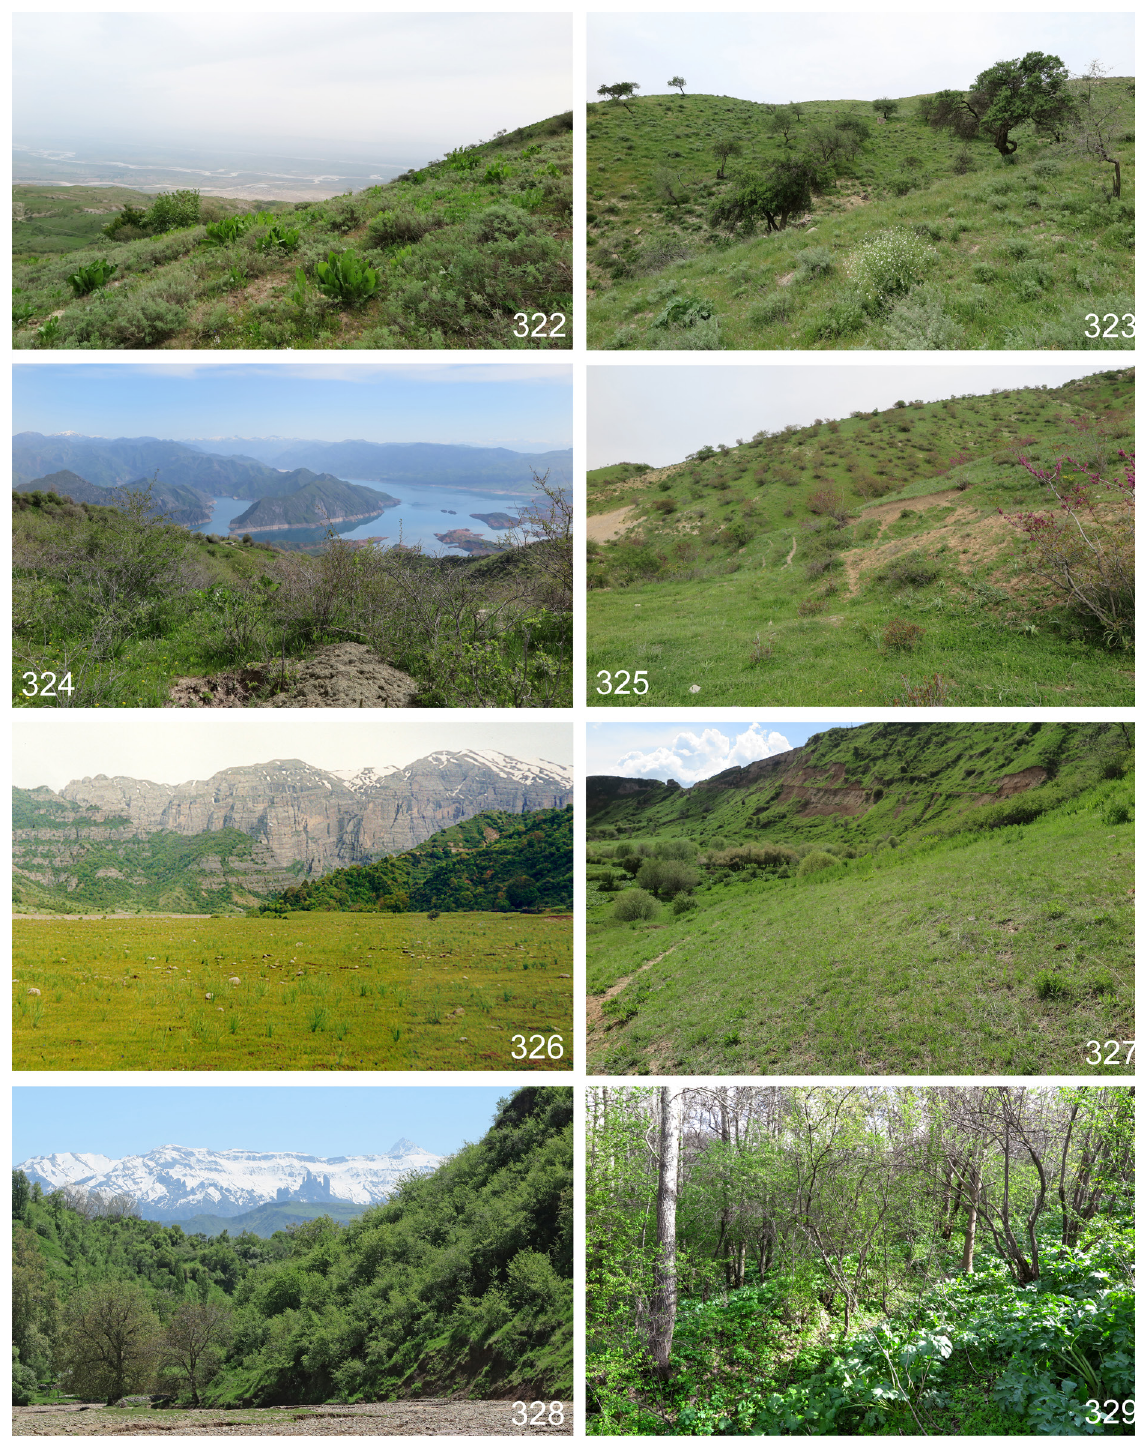
Figs 322–329. Anemesia spp., habitats of A. infumata sp. nov. (322–323), A. parvula sp. nov. (324) and A. infuscata sp. nov. (324–329); Tajikistan. 322–323 . Summit part of Panj Karatau Mts north of the Panj River bordering Tajikistan and Afghanistan. 324–325 . Summit part of Sanglok Mts., south of the Nurek Reservoir. 326 . Midland zone of Hazratisho Mts (Sangdara), 327 . Same, Kuhitek Mts (east of Hovaling). 328–329 . Same, Mazar Mts